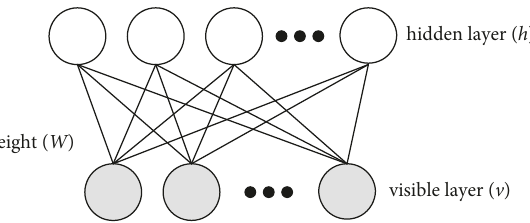
Figure 3: Restricted Boltzmann machine model.